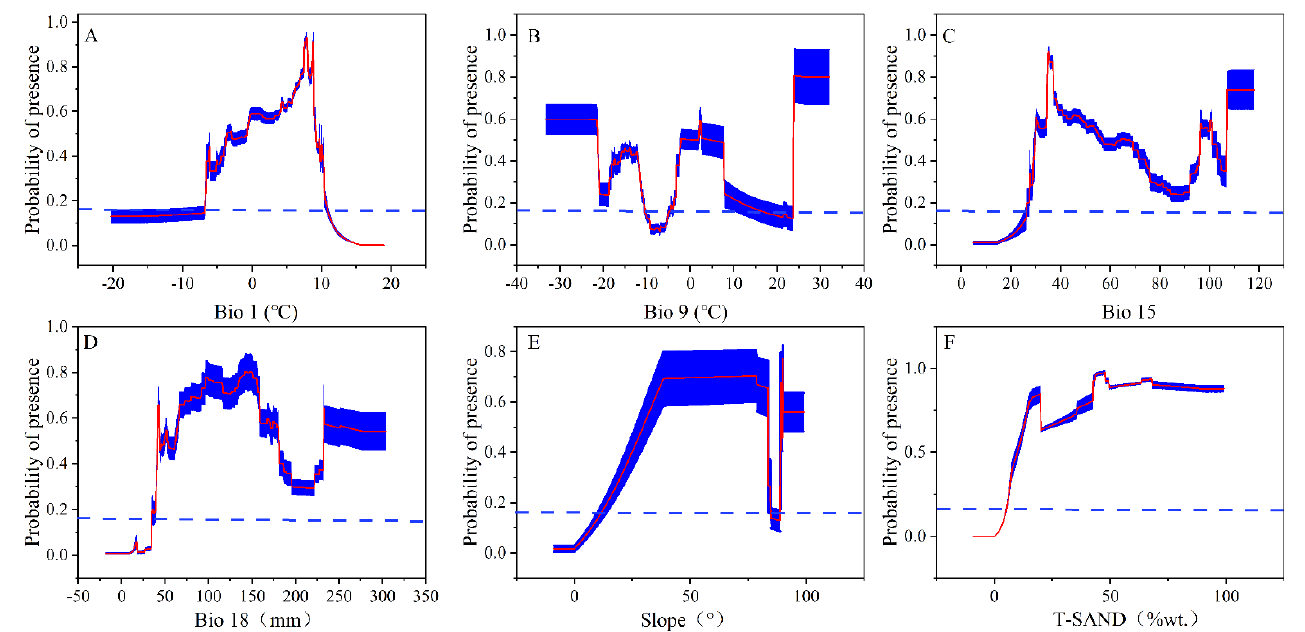
Figure 6. Response curves for the six most critical environmental variables. (A) – (F): Bio1, Bio9, Bio15, Bio18, Slope, T-SAND. The red curve and blue shading indicate the mean response and mean +/− one standard deviation for the 10 MaxEnt replicate runs. The blue dashed line indicates the maximum training sensitivity plus specificity threshold.